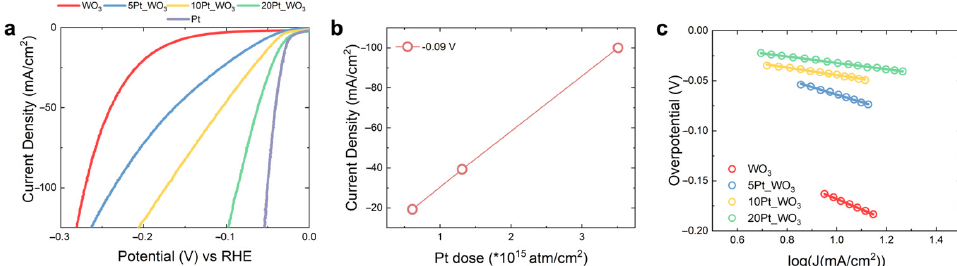
Figure 2. ( a ) LSV curves of the WO 3 , the 5Pt_WO 3 , the 10Pt_WO 3 , and the 20Pt_WO 3 electrodes (red, blue, yellow, and green lines, respectively); ( b ) current density at − 0.09 V as a function of Pt dose of the 5Pt_WO 3 , the 10Pt_WO 3 , and the 20Pt_WO 3 electrodes; ( c ) Tafel plot and liner fit of WO 3 , 5Pt_WO 3 , the 10Pt_WO 3 , and the 20Pt_WO 3 electrodes (red, blue, yellow, and green circles and